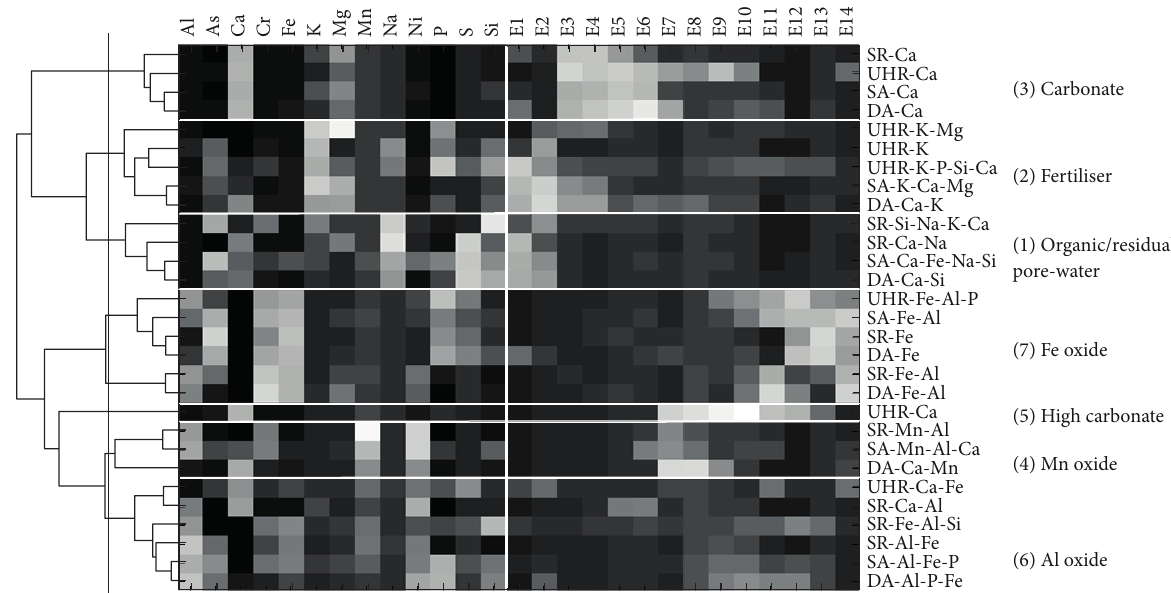
Figure 6: Colourmap and associated clustergram for CISED extract data for a selection of the test soils. The dendrogram along the left-hand side shows how individual components link together. The horizontal line divides the colourmap into clusters and the vertical line separates the element compositions data on the left-hand side from the extraction number data on the right. A high proportion of each component and an indication of its composition are shown by a white or pale grey colouration with a low proportion as dark grey or